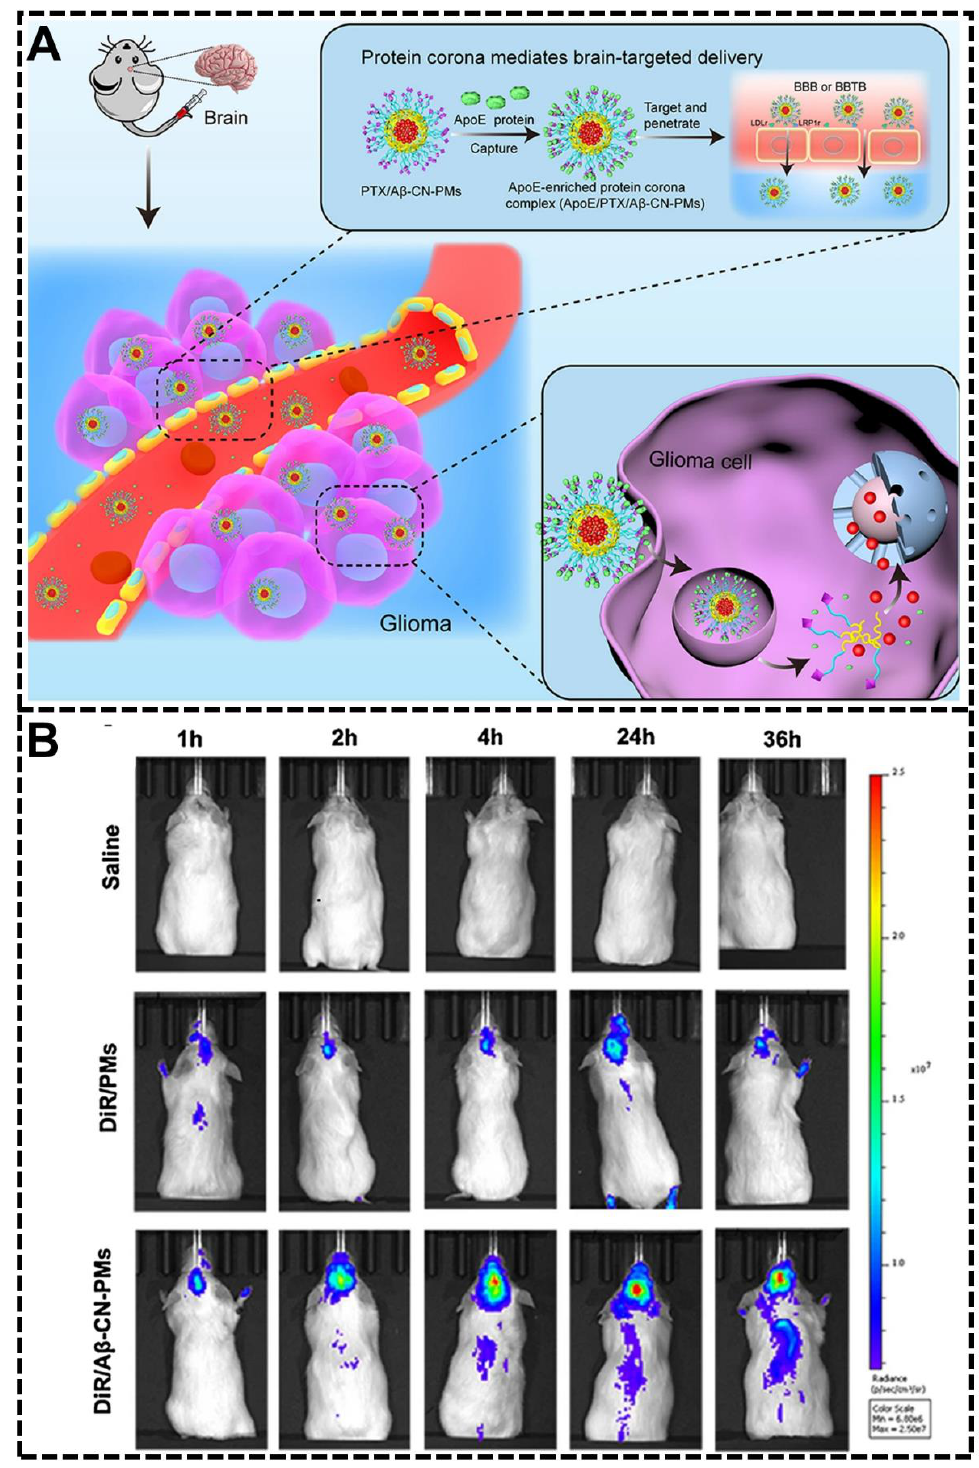
Figure 9. Biomimetic peptides modification to harness protein corona. ( A ) The A β -CN peptide modification will capture the ApoE in the biological fluids and form the ApoE-enriched protein corona for brain-targeting [92]. Copyright 2021, Springer Nature. ( B ) The in vivo fluorescence imaging of orthotopic glioma-bearing mice treated with saline, DiR/PMs, and DiR/A β -CN-PMs at different time points [92]. Copyright 2021, Springer Nature.